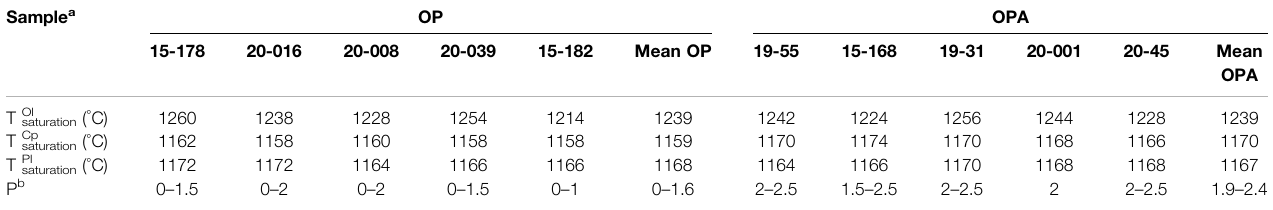
TABLE 3 | Results of thermodynamic modelling of mineral saturation conditions for Cracked Mountain magma suites, including olivine (Ol), clinopyroxene (Cp), and plagioclase (Pl) mineral saturation temperatures and maximum pressure limits based on simulations with Rhyolite_MELTS. Sample a